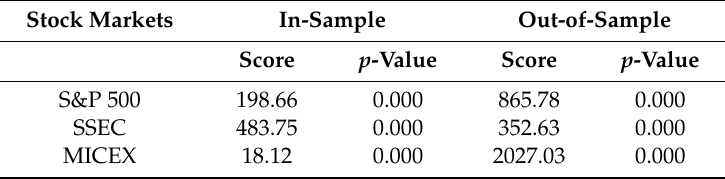
Table 3. Jarque-Bera Normality Test of S&P 500, SSEC, and MICEX.